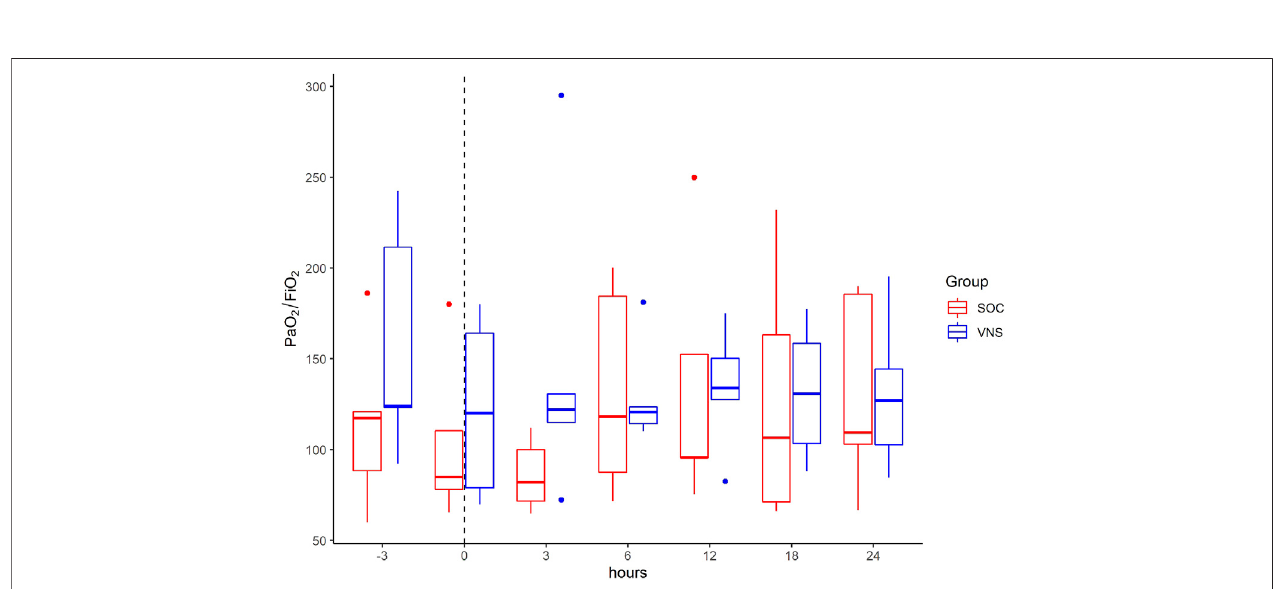
FIGURE12 | Median Horowitz index (PaO 2 /FiO 2 ) withInterquartile Range ofpatientsreceivingauricular Vagus Stimulation (VNS =blue) and patientsonly receiving Standard of Care (SOC = red) prior to, at time of study inclusion (dashed line) and up to 24h afterwards.